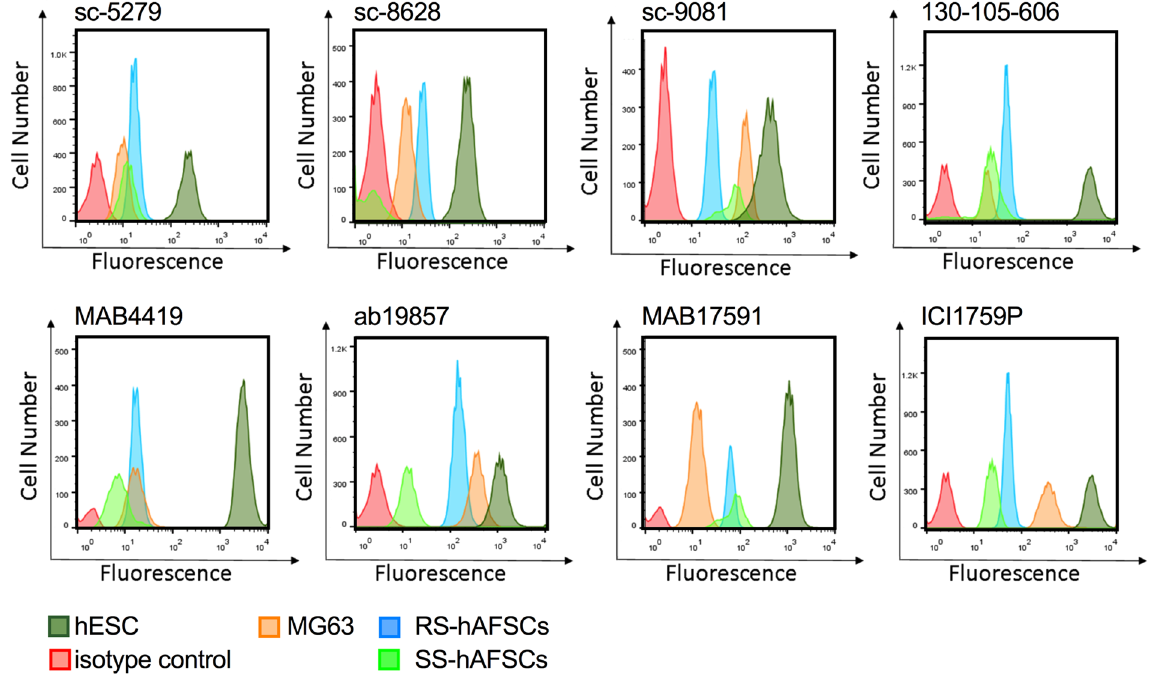
Figure 4. Flow cytometry analysis of hAFSCs. Flow cytometry showing OCT4 expression in hESCs (dark green tracing), MG63 (yellow tracing), RS-hAFSCs (blue tracing) and SS-hAFSC (light green tracing) using the antibodies shown. The red tracing shows the primary antibody only